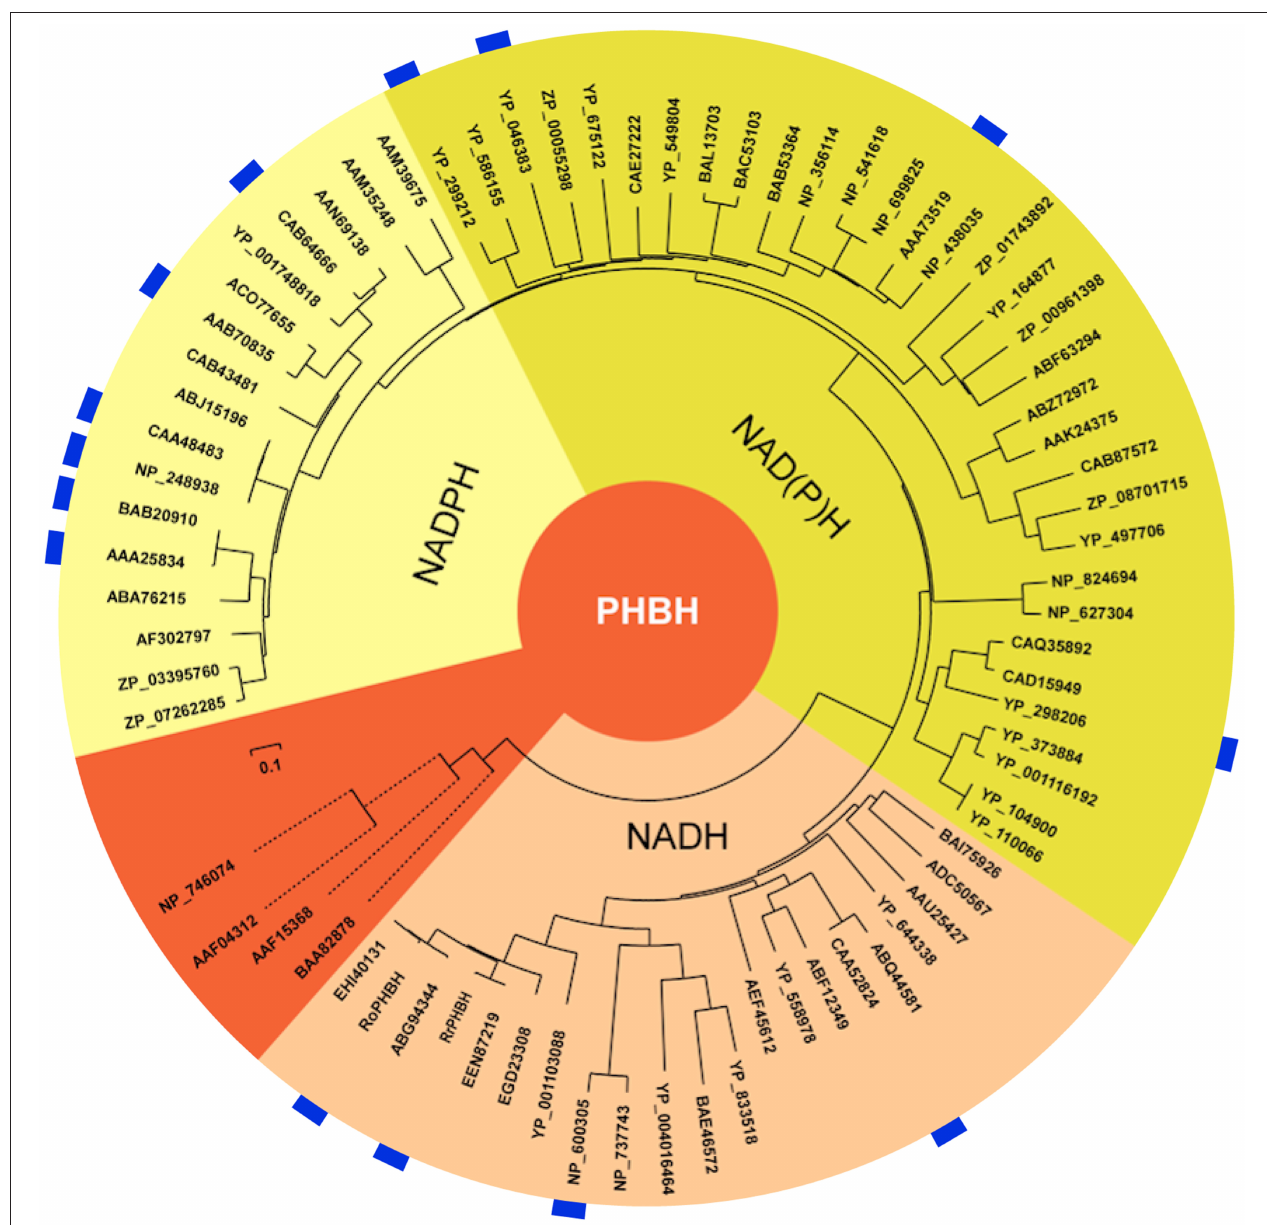
FIGURE 4 | Distance tree illustrating the sequence similarities and predicted pyridine nucleotide coenzyme specificities of PHBHs. The distance tree is based on a similar alignment as that in Figure 2 , but now with 74 sequences ( Figure S1 ). The biochemically characterized PHBHs ( Table 1 ) are indicated in blue. The additional accession numbers for (putative) PHBHs are as follows: Acinetobacter sp. ADP1, YP_046383; Agrobacterium tumefaciens C58, NP_356114; Arthrobacter sp. FB24, YP_833518; Azospirillum sp. B510, BAI75926; Azotobacter chroococcum , AAB70835; Azotobacter vinelandii DJ, ACO77655; Bacillus licheniformis ATCC 14580, AAU25427; Bacillus pseudofirmus OF4, ADC50567; Bradyrhizobium japonicum USDA 110, BAC53103; Bradyrhizobium japonicum USDA 6, BAL13703; Brucella melitensis bv. 1 16M, NP_541618; Brucella suis 1330, NP_699825; Burkholderia mallei ATCC 23344, YP_104900; Burkholderia pseudomallei K96243,